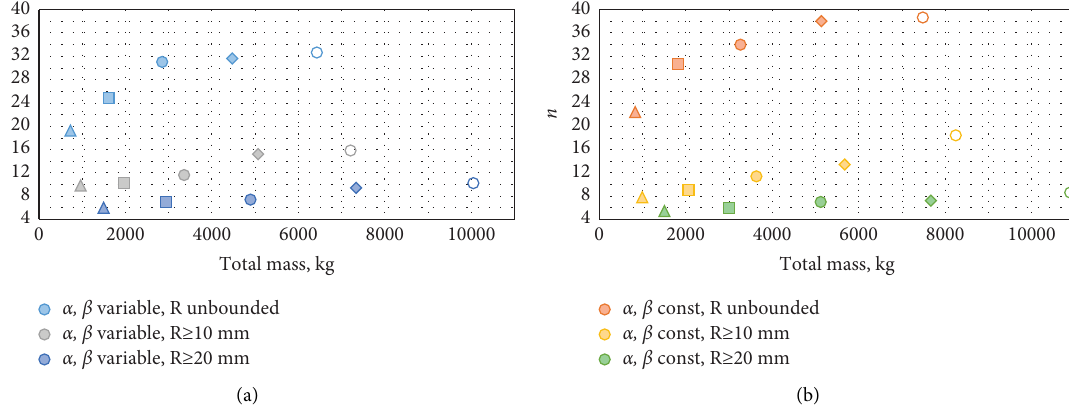
Figure 10: Average values of section number n : (a) α , β variable and (b) α , β